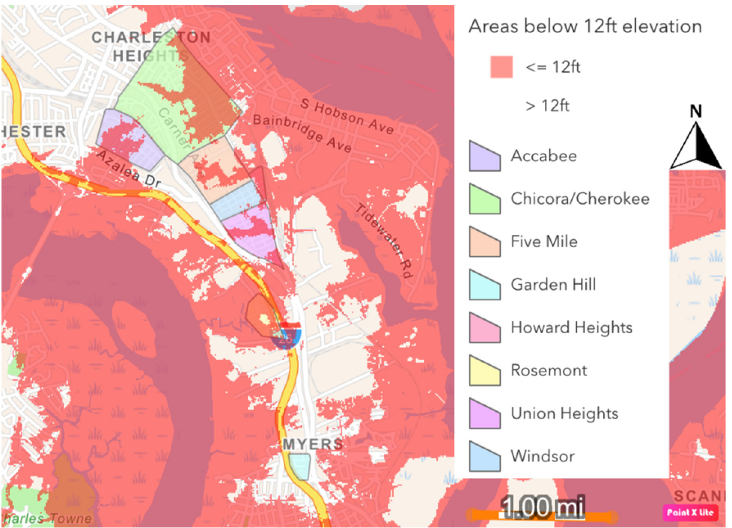
Figure 6. Parts of the Charleston Neck under 12 ft (3.7 m) elevation (in red), in relation to Charleston Neck communities. Digital Elevation Model (DEM) developed by the Lowcountry Hazards Center at the College of Charleston.